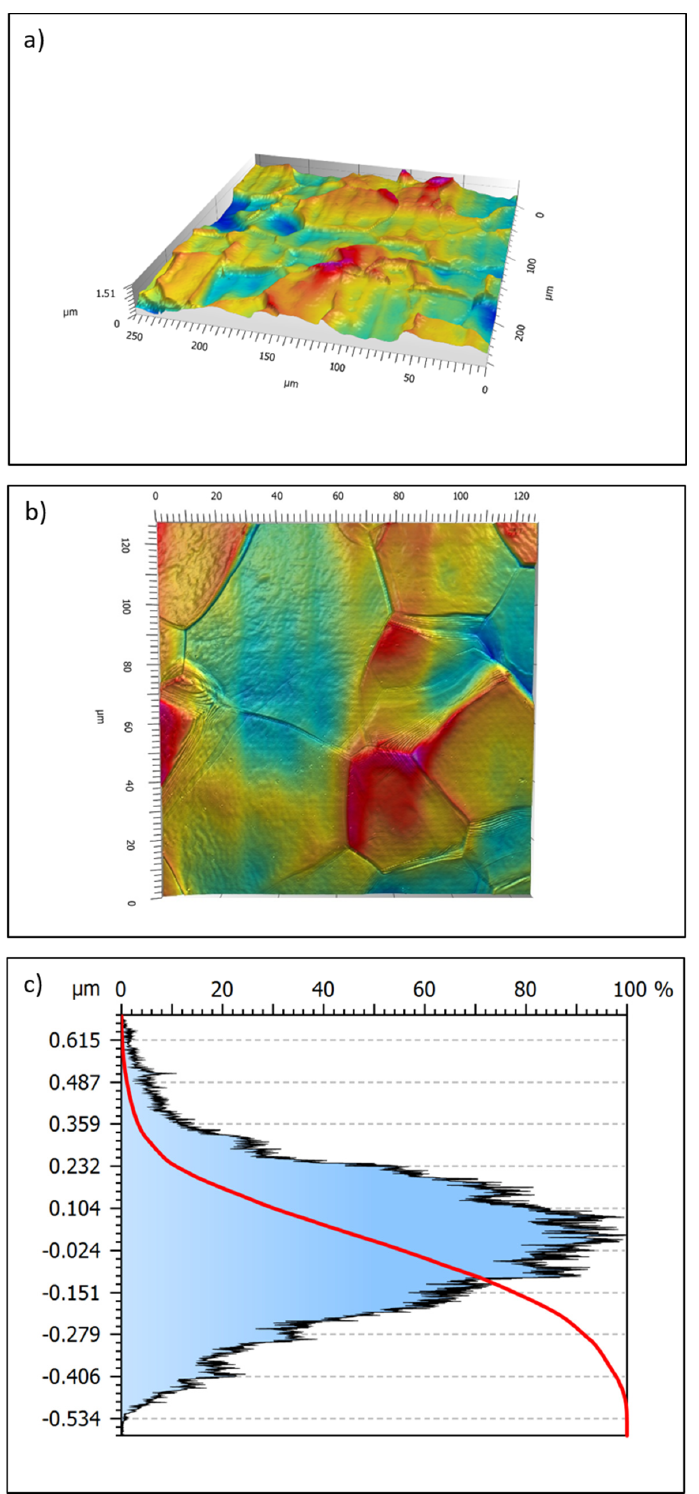
Figure 3. Confocal microscope images of EB10 sample; 50× ( a ) and 100× ( b ) magnifications. In the frame ( c ) the Abbott–Firestone curve is reported.